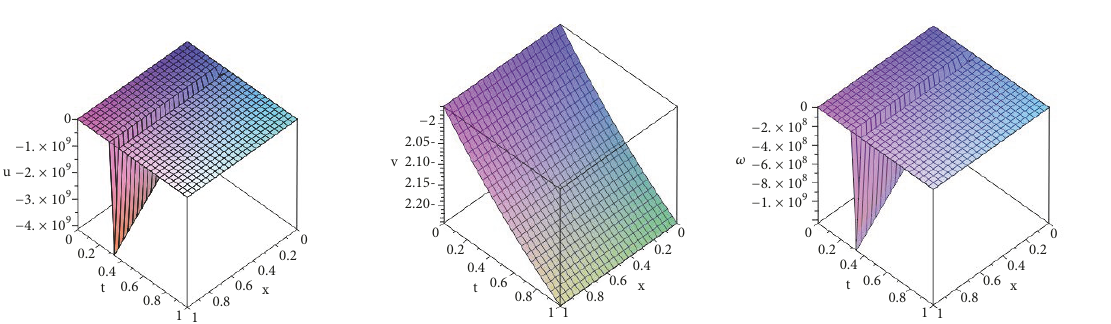
Figure 8: Surface of 𝑢 , V , and 𝜔 for 𝑀 = 1 , S = 5 , 𝛾 = 0.5 , 𝑦 = 1 , 𝛼 = 3 , 𝑙 = 2 .